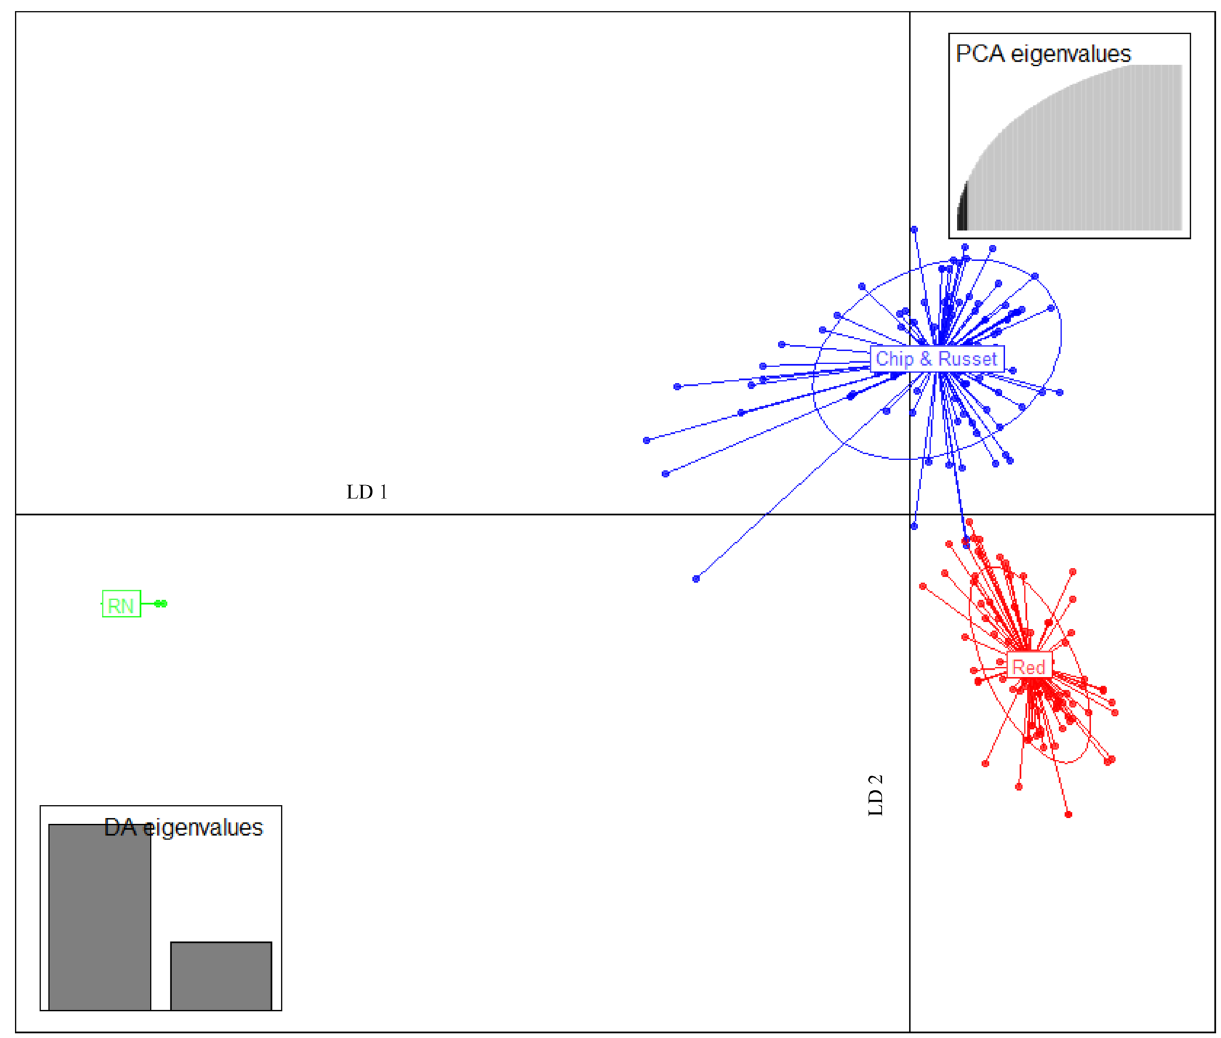
Figure 5. Discriminant analysis of principal components (DAPC) for 214 clones using adegenet R package 67 . The axes represent the first two linear discriminants (LD). Circumferences surround each group, and small solid dots represent individual clones. Labels inside circles indicate the different subpopulations identified by DAPC analysis (Chip & Russet = chipping and russet clones, Red = red/specialties, and RN = Russet Norkotah and its